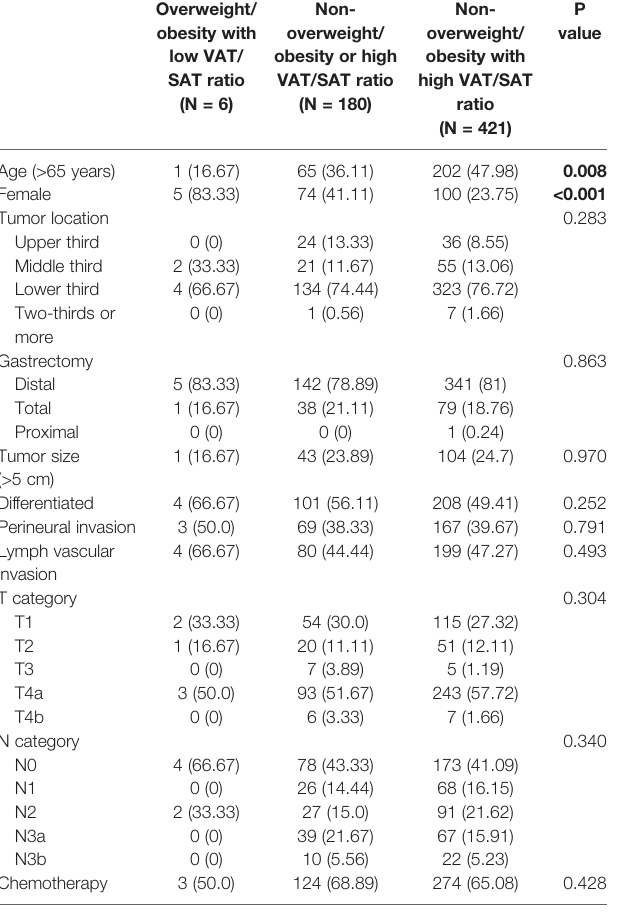
TABLE 4 | Characteristics of entire cohort and classi fi ed by overweight/obesity and VAT/SAT ratio. Overweight/ obesity with